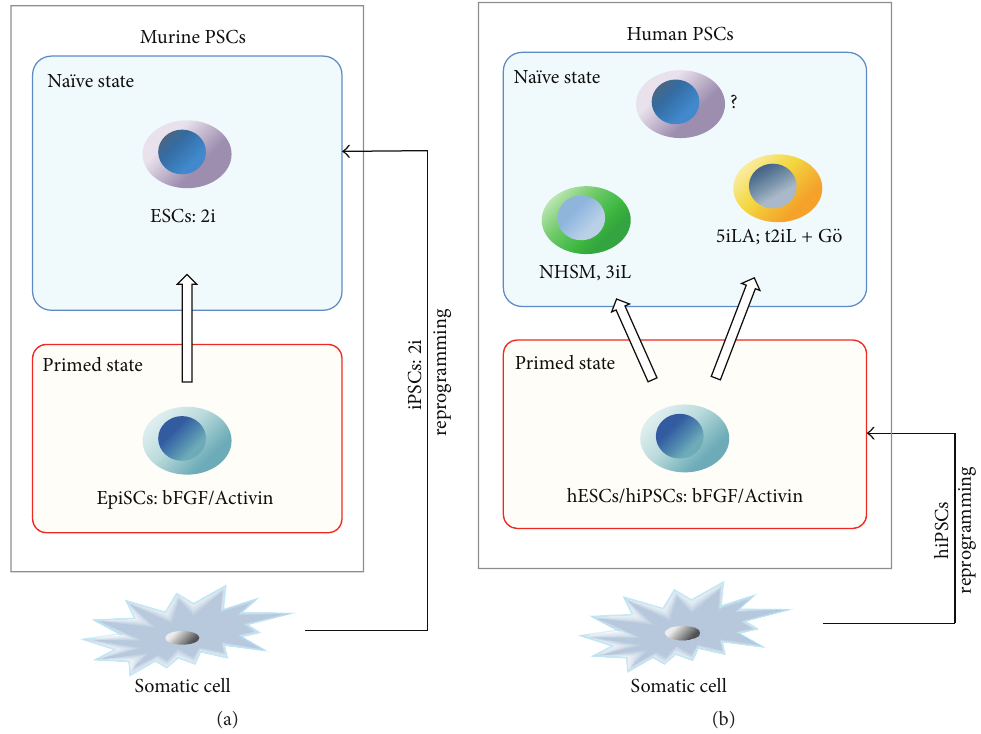
Figure 4: Visual comparison of murine and human PSCs. (a) In mouse, ESCs and EpiSCs are characterized by a different pluripotent state, called na¨ıve and primed, respectively, which reflects their embryonic origin. The stability and homogeneity of mESCs cultured in 2i represent a developmental ground state closely reflective that of the ICM of preimplantation blastocysts. Pluripotent stem cell can be obtained also by reprogramming of somatic cells. Mouse iPSCs, cultured in 2i, show a ground state similar to mESCs. (b) Human ESCs and iPSCs cultured in presence of bFGF/Activin are in the primed state. Different conditions have been established to convert primed hESCs and hiPSCs into a na¨ıve state. The initial comparative analysis of the na¨ıve human cell lines clearly indicates that the various culture conditions induce different pluripotent states, each showing similar features, but not identical, to those of na¨ıve mESCs. Whether the authentic pluripotent ground state of na¨ıve hESCs is identical to that of mESCs, it is still to be determined.